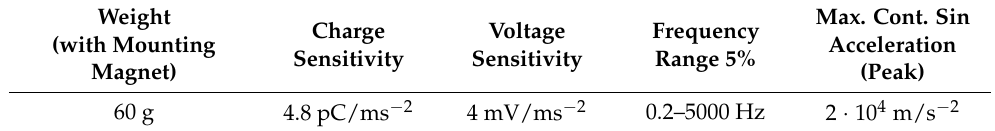
Table 1. PZT accelerometers